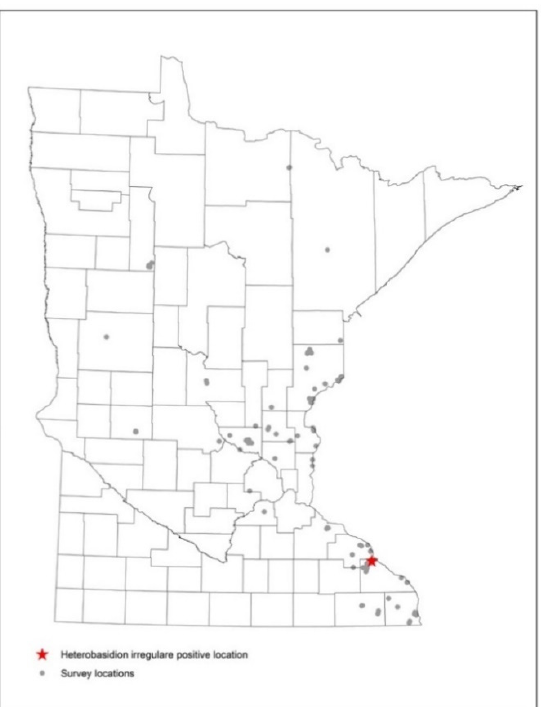
Figure 1. Survey locations for H. irregulare showing results from culturing studies with gray dots as negative locations and the red star as the positive location for the pathogen.